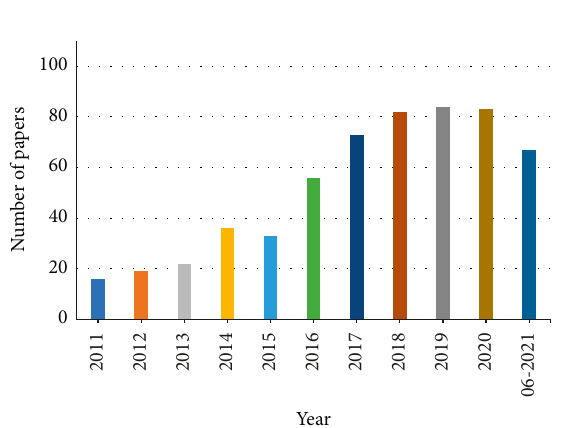
Figure 1: Statistics of the total papers published per year.